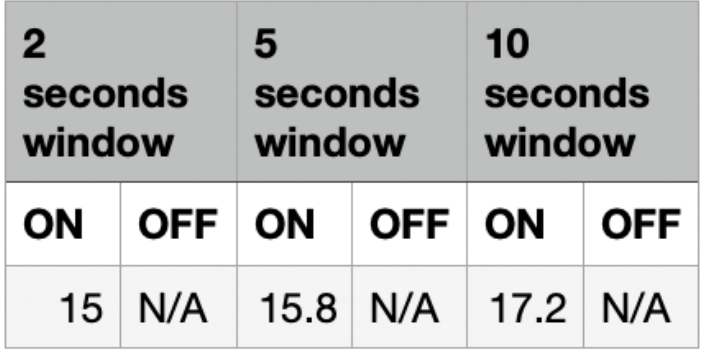
Figure 10. Response